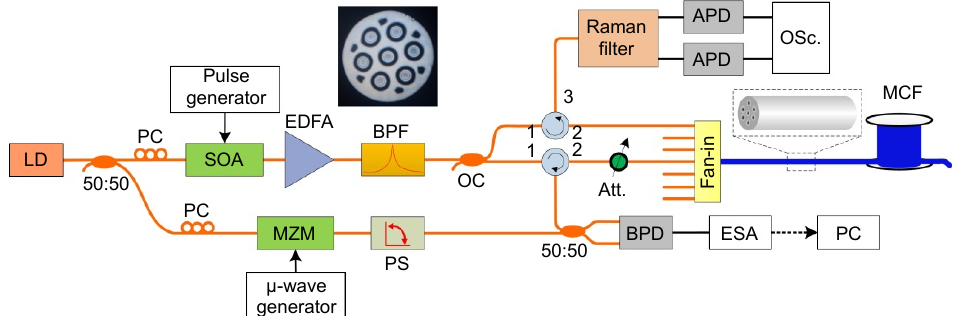
Fig. 11 | Experimental setup of the MCF based SDM ROTDR and BOTDR hybrid system. LD: Laser diode; PC: polarization controller; SOA: semiconductor optical amplifier; MZM: Mach-Zehnder modulator; EDFA: erbium-doped fiber amplifier; PS: polarization switch; BPF: bandpass filter; BPD: balanced photodetector; Att.: tunable attenuator; APD: avalanche photodiode; ESA: electrical spectrum analyzer; OSc.: oscilloscope; the inset shows the cross-section view of the used MCF in the experiment. Figure reproduced from ref. 53 , Optical Society of America.